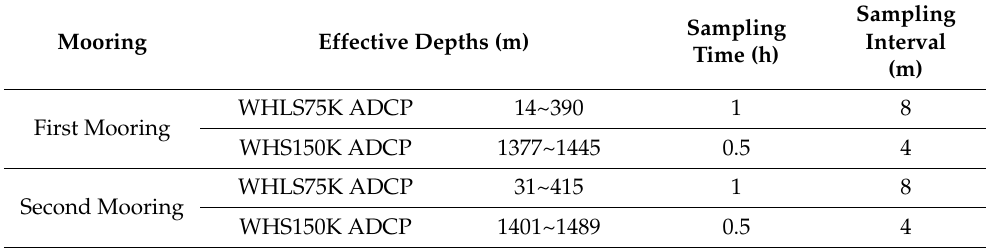
Figure 1. The topography of southern SCS and the observation location of the mooring site are marked by the star (red). Three hourly tracks of “Nameless” storms (SID: 2010018N07113, January storm; green dot solid line; and SID: 2010346N09115, December storm, orange dot solid line) are denoted. Table 1. Observational data.